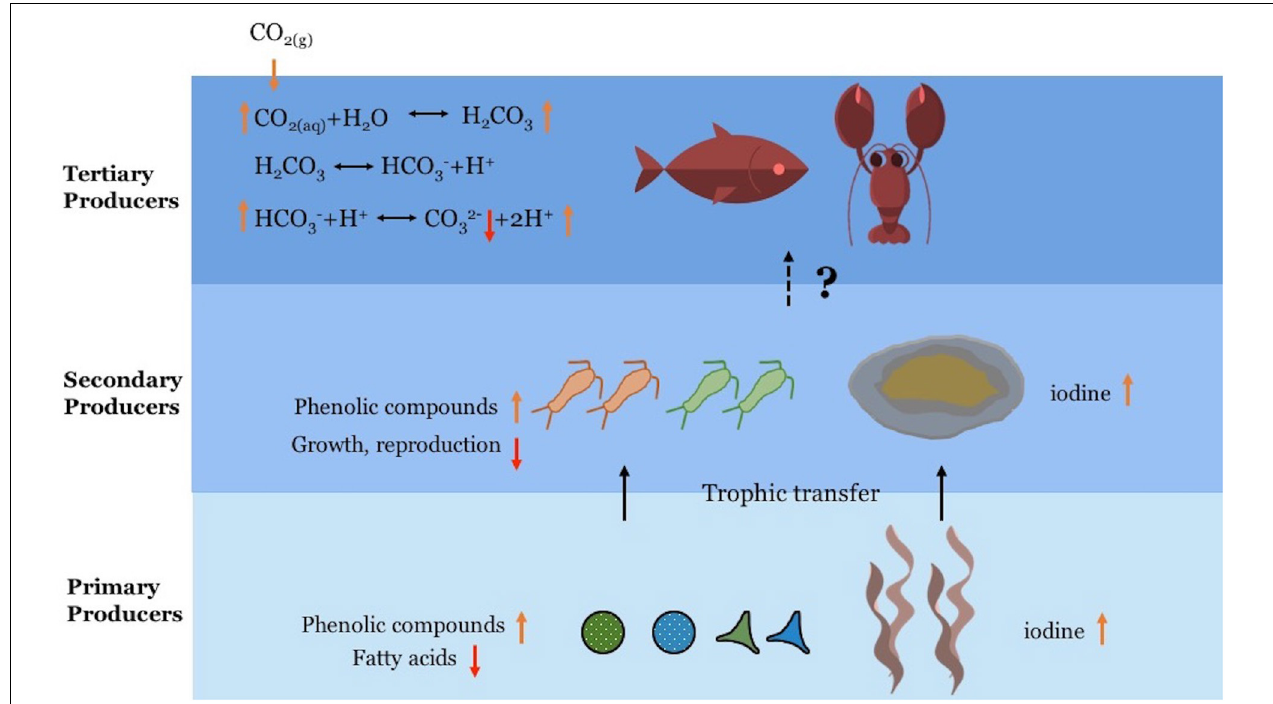
FIGURE 2 | Conceptual diagram showing the food chain effects of ocean acidification (OA). OA increased the contents of phenolic compounds and iodine in the primary producers (phytoplankton and kelp), and these changes lead to accumulation in the secondary producers that feed on them. Whether these food chain effects can scale up in multiple trophic levels (e. g. primary to secondary to tertiary producers) needs further investigation. The orange arrows indicate increased and red ones indicate decreased levels of the compounds, growth or